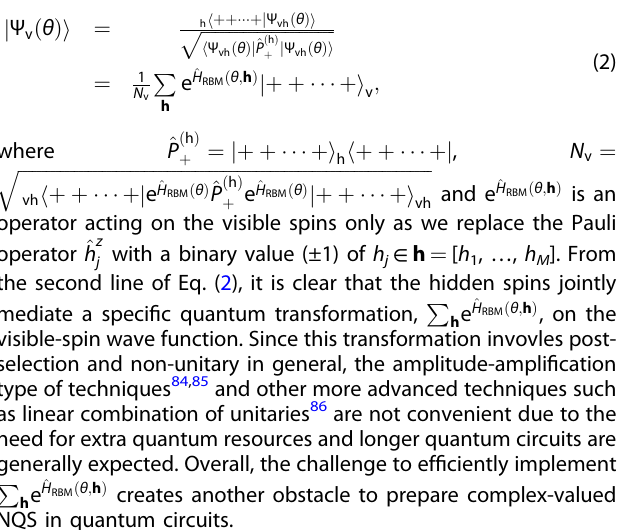
Fig. 1a, the single-qubit rotations R n ( θ ) are determined via relations of the form exp b R